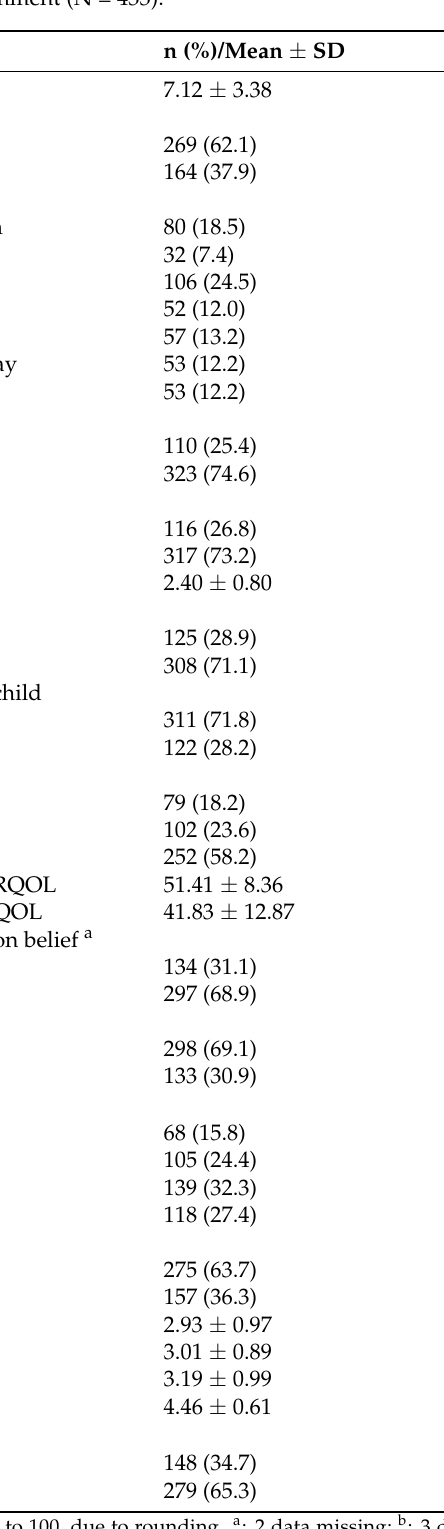
Table 2. Characteristics of child, family, and environment (N =